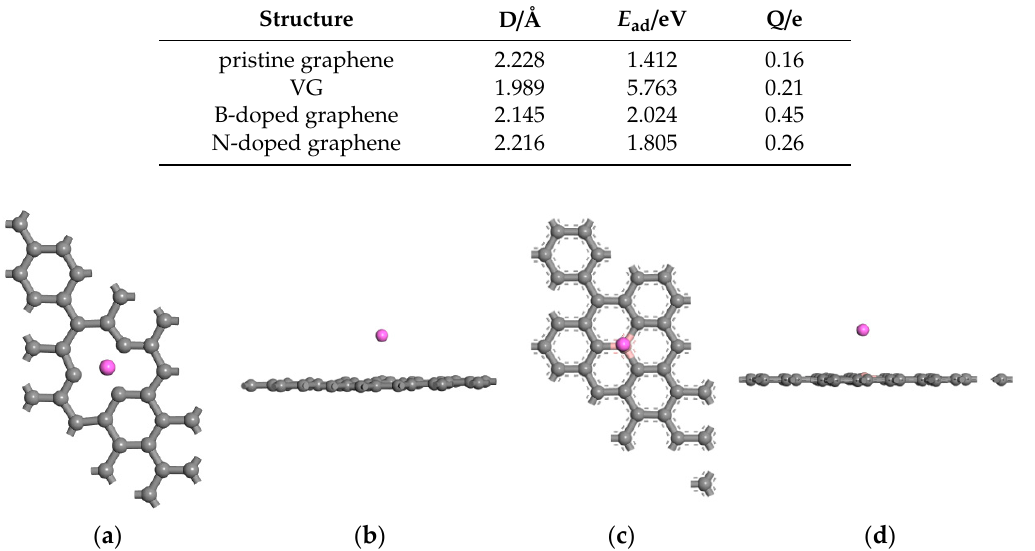
Figure 2. The front view and the top view of graphene with adsorbed Al atom: ( a ) the top view of VG with adsorbed Al atom; ( b ) the front view of VG with adsorbed Al atom; ( c ) the top view of B-doped graphene with adsorbed Al atom; ( d ) the front view of B-doped graphene with adsorbed Al atom.